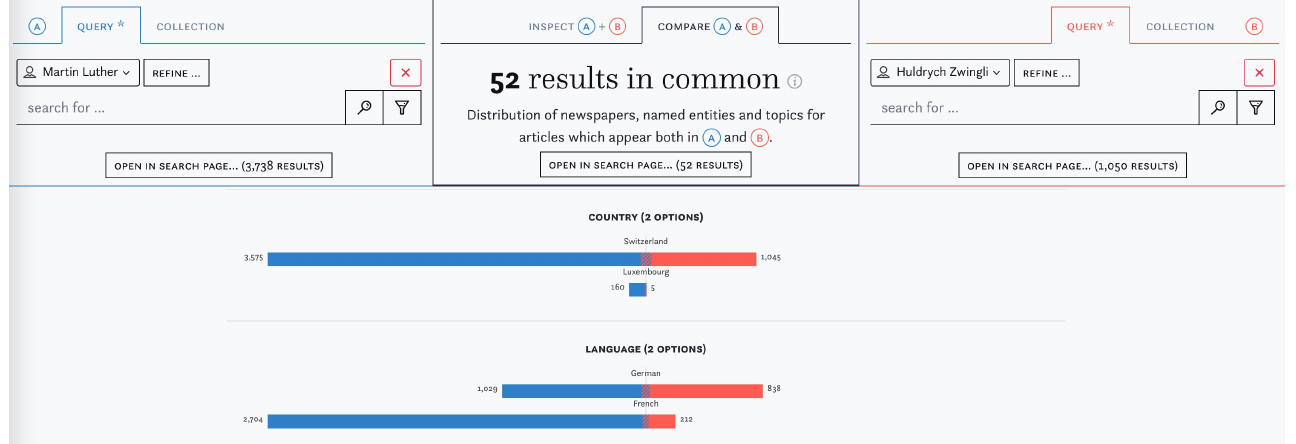
Figure 4. Comparison of the linked entities “Martin Luther” and “Huldrych